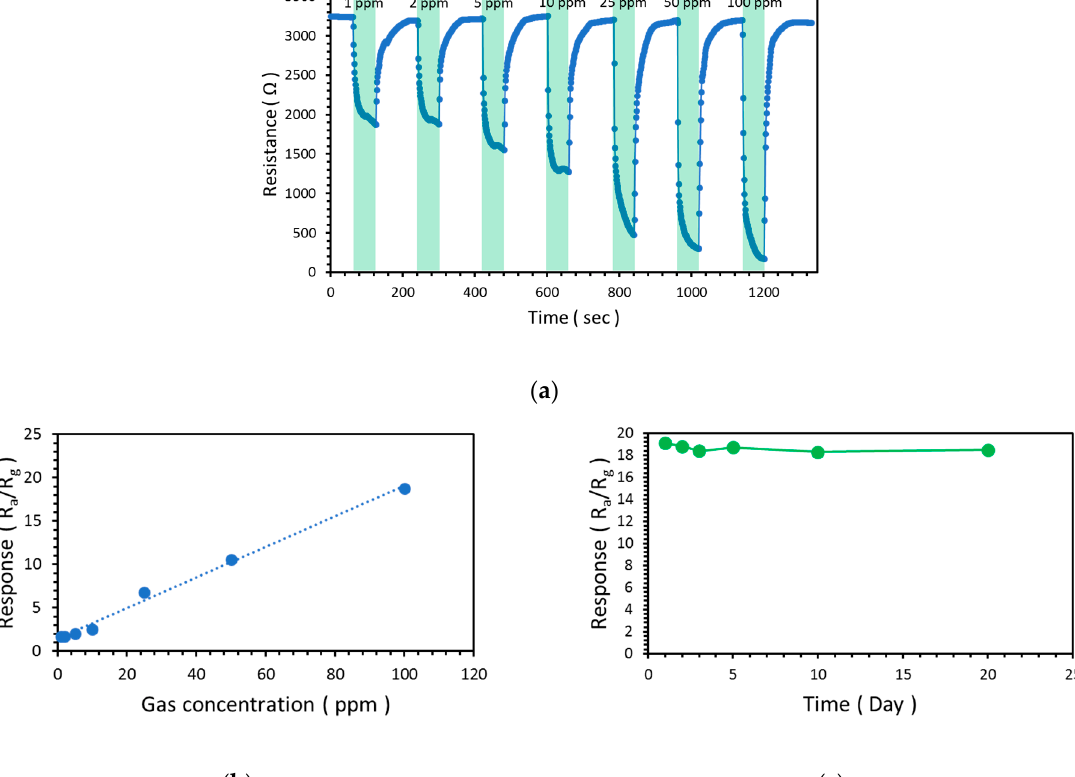
Figure 12. ( a ) Resistance change and ( b ) response of ZnO NW vines decorated with 0.05 M α -Fe 2 O 3 to CO at concentrations ranging from 1 to 100 ppm at 300 °C, and ( c ) response stability of ZnO NW vines decorated with 0.05 M α -Fe 2 O 3 toward 100ppm CO at 300 °C. Table 4. Resistances and response of 0.05 M α -Fe 2 O 3 /ZnO NW vines according to gas concentration. Gas Concentration (ppm) 1